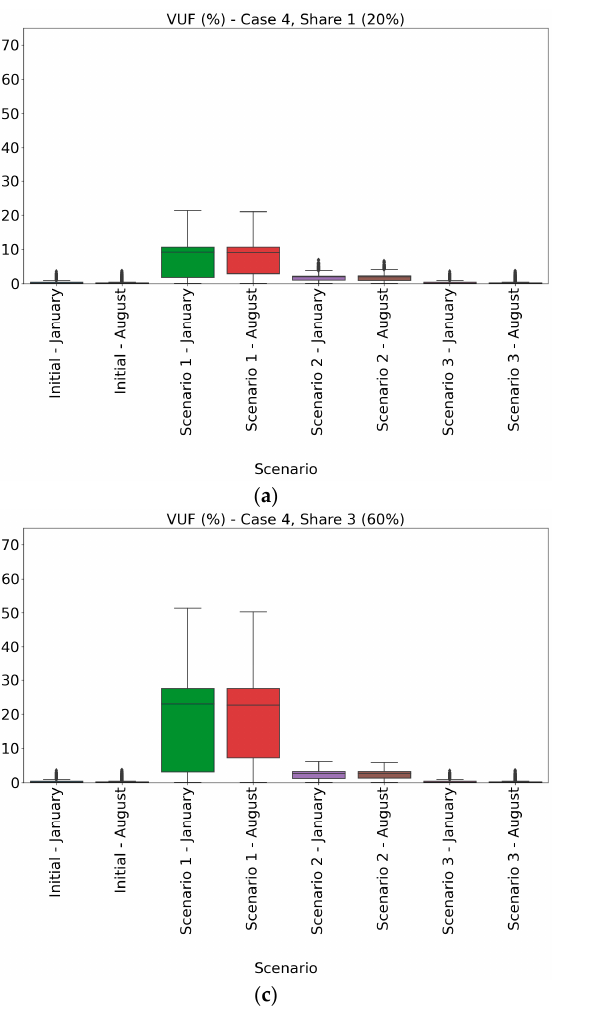
Figure 8. VUF (%)—Case 4; Share 1–Share 4; January, August.